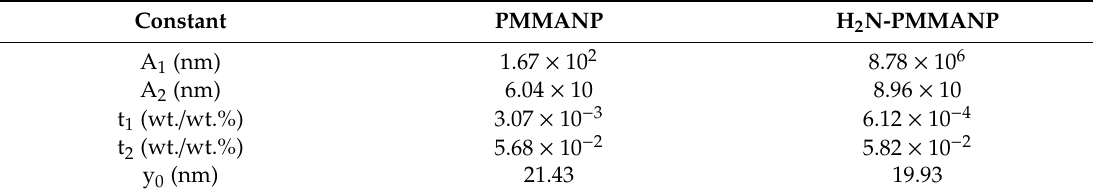
Table 3. Respective Values for Constants in the Fitted